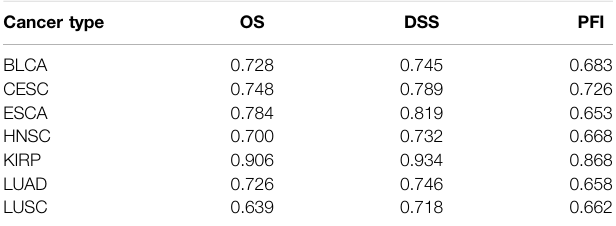
TABLE 2 | The C-index of the nomograms was used to predict the prognostic indicators in each cancer type. Cancer